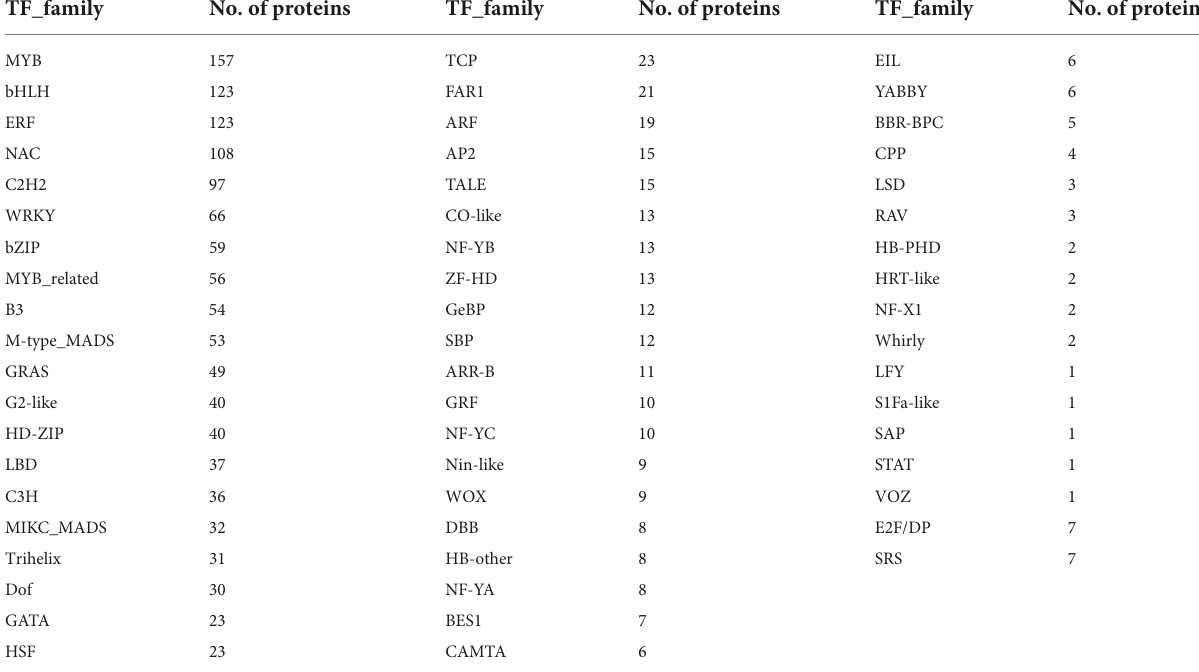
TABLE 6 Transcription factor families and their counts in